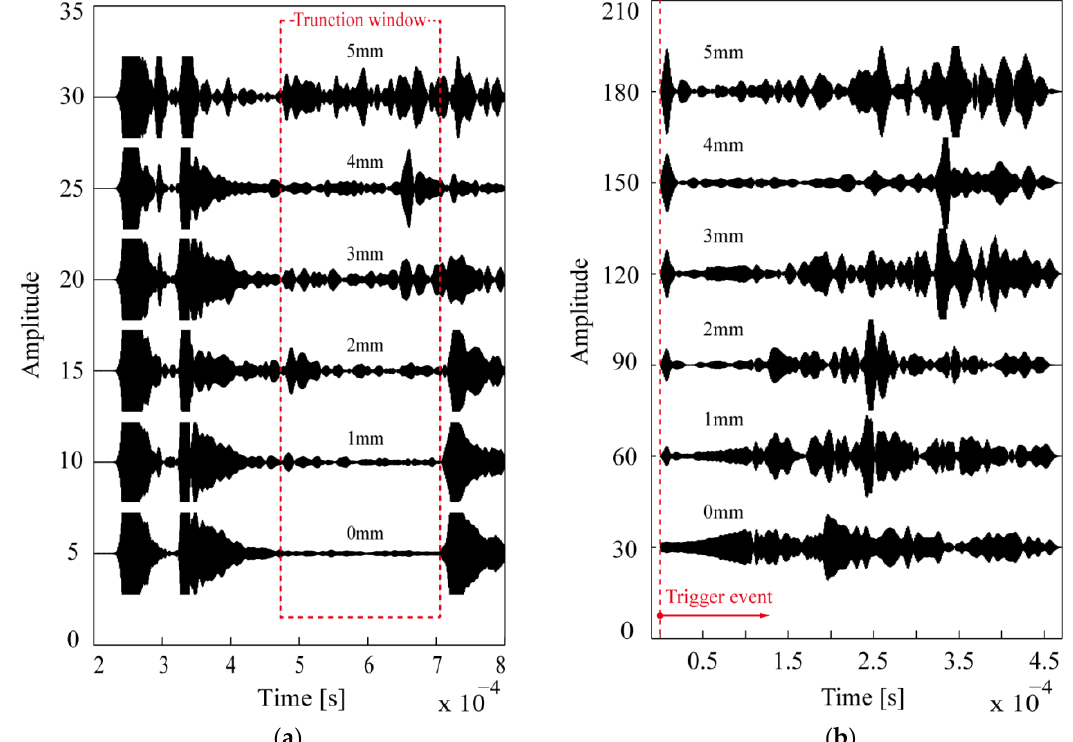
Figure 8. TRM process of defect assessment: ( a ) received signals before TRM; ( b ) received signals after TRM.